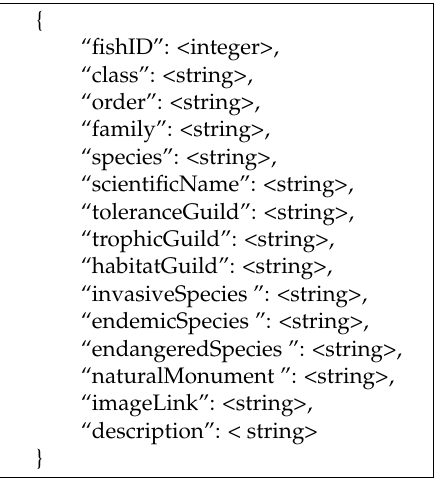
Algorithm 2. Representation schema for the Fish collection